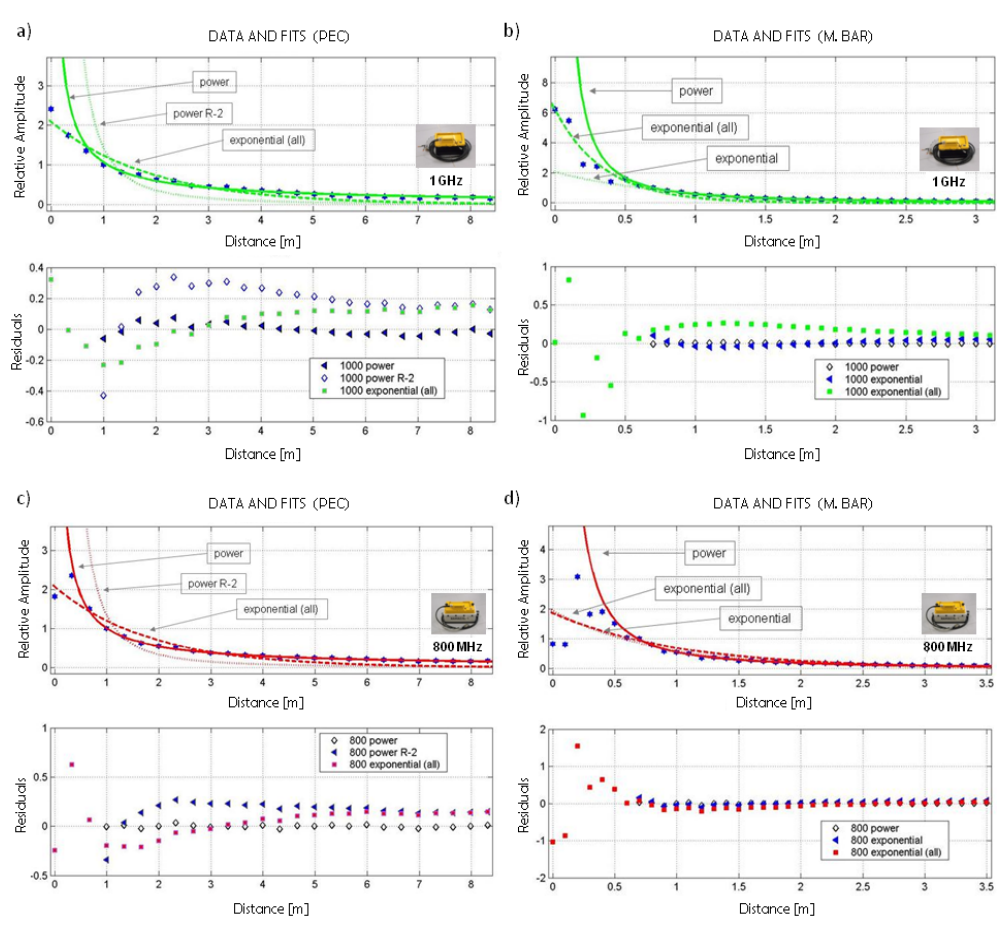
Figure 10 . Maximum amplitude peaks of the reflected wavelet at different distances. For each methodology, three possible regression curves and their residual variations are shown. (a-b) PEC and metallic bar for the 1 GHz antenna. (c-d) PEC and metallic bar for the 800 MHz antenna.